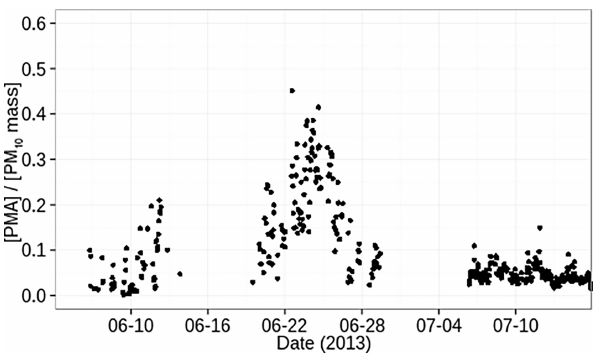
Figure 5. Ratio of inorganic sea salt mass concentration (PILS-IC) over PM 10 mass concentration (TEOM PM 10